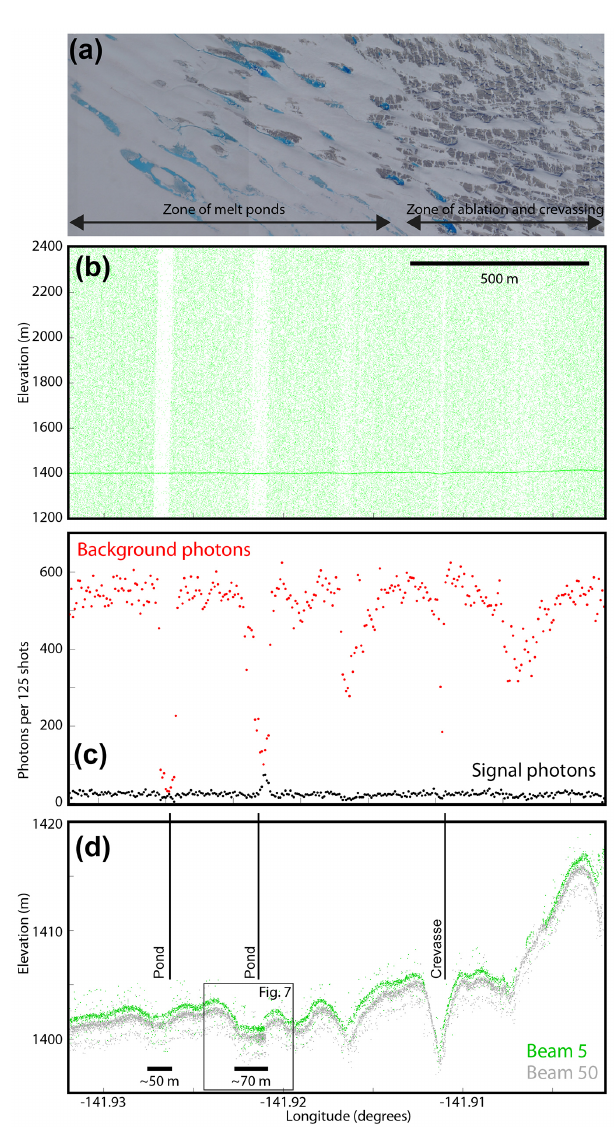
Figure 6. MABEL camera and photon data over crevasse and melt- pond fields on the Bagley Icefield, from the 16 July 2014 flight. (a) Stitched MABEL camera images. (b) MABEL signal and back- ground photons for a 1200m range that includes the glacier surface. (c) Signal (black) and background (red) photon counts per 125 shots (approximately 2.5m of along-track distance). (d) MABEL signal photons, indicating the location of melt ponds; the ponds indicated are approximately 50 and 70m in along-track length. Figure 7 is a histogram of the ∼ 70m pond. The 1064nm beam shows evidence of a secondary return 1.5m below the main signal return, due to un- intended secondary pulses from the MABEL laser that occur under some operational conditions. The along-track slope of the crevasse field, between 141.93 and 141.91 ◦ W longitude, is approximately 0.5 ◦ .